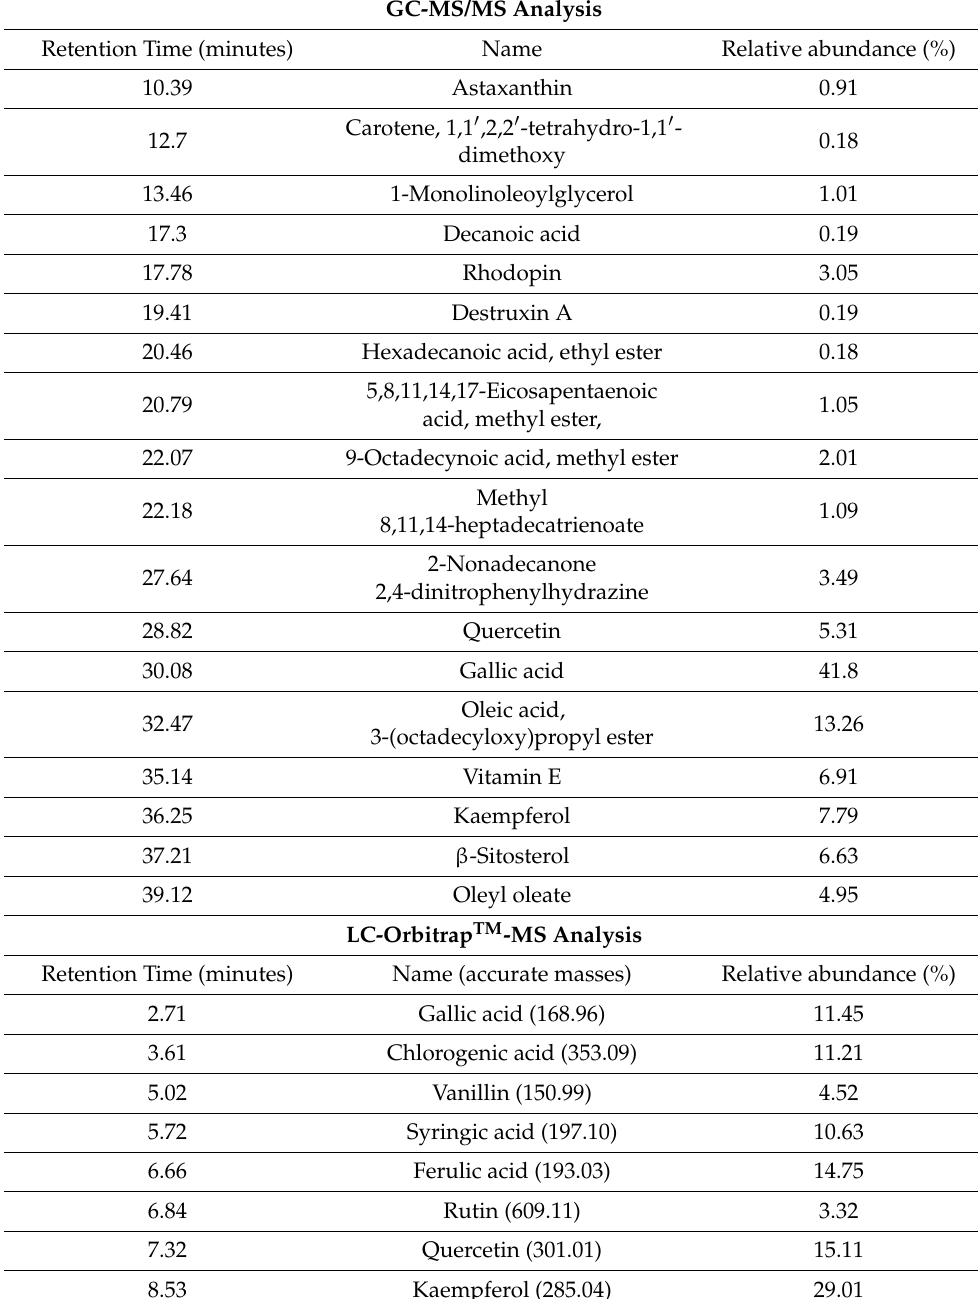
Table 1. List of identified compounds and accurate